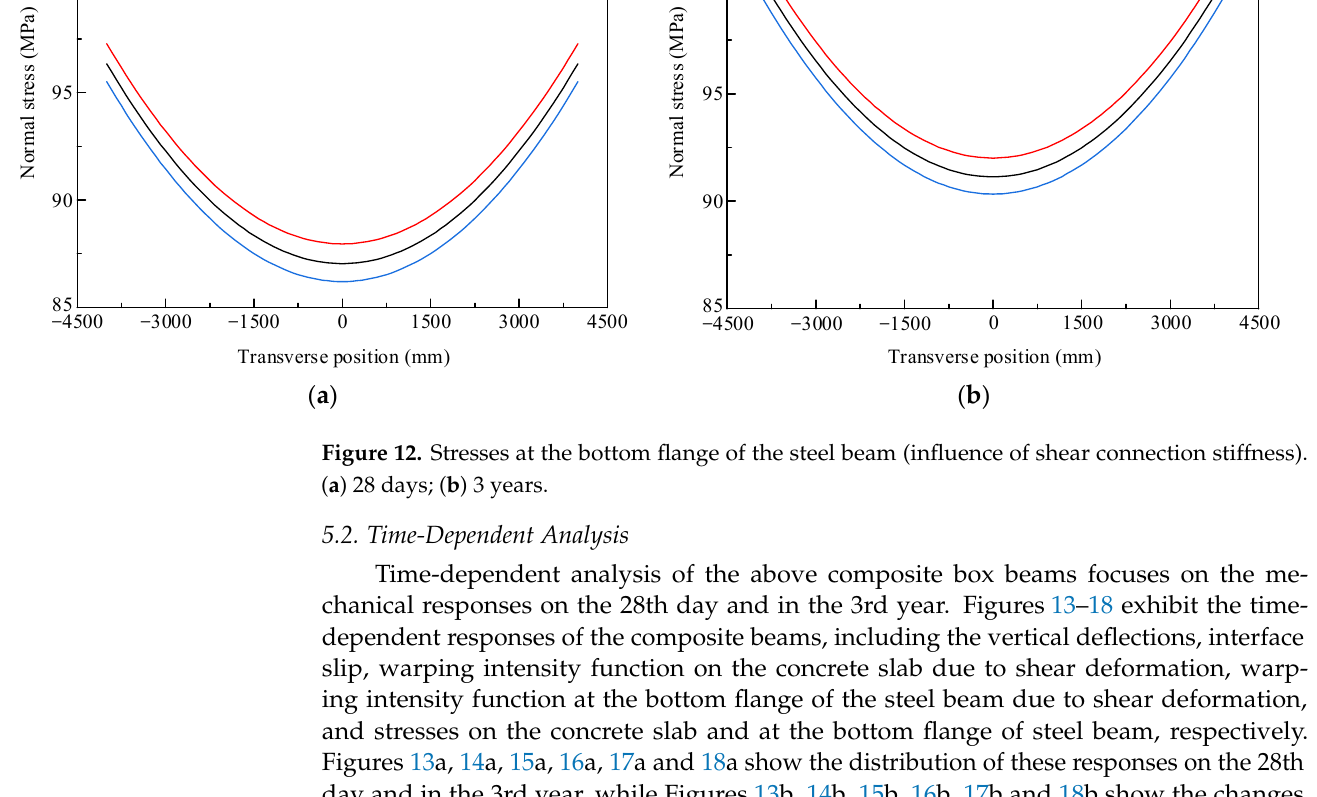
Figure 12. Stresses at the bottom flange of the steel beam (influence of shear connection stiffness). ( a ) 28 days; ( b ) 3 years.